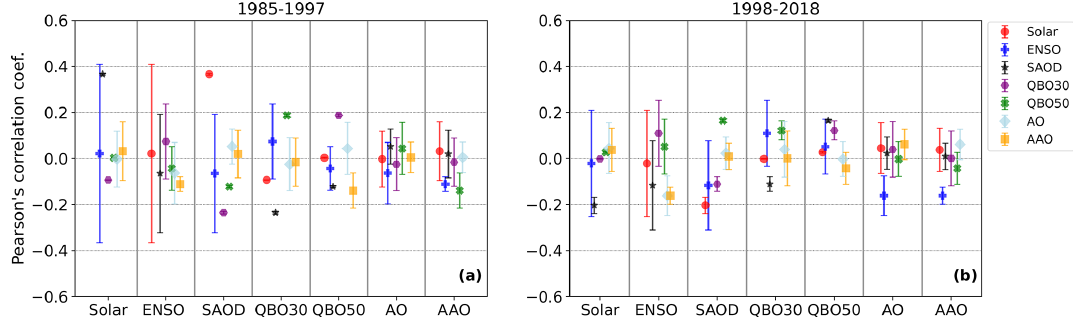
Figure 1. Pearson’s linear correlation coefficients for different covariate variables (proxy variables) of the SOCOLv4 ensemble experiment for the (a) ozone depletion phase (1985–1997) and the (b) ozone recovery phase (1998–2018). Error bars represent the 2 σ standard deviation of correlation coefficients between ensemble